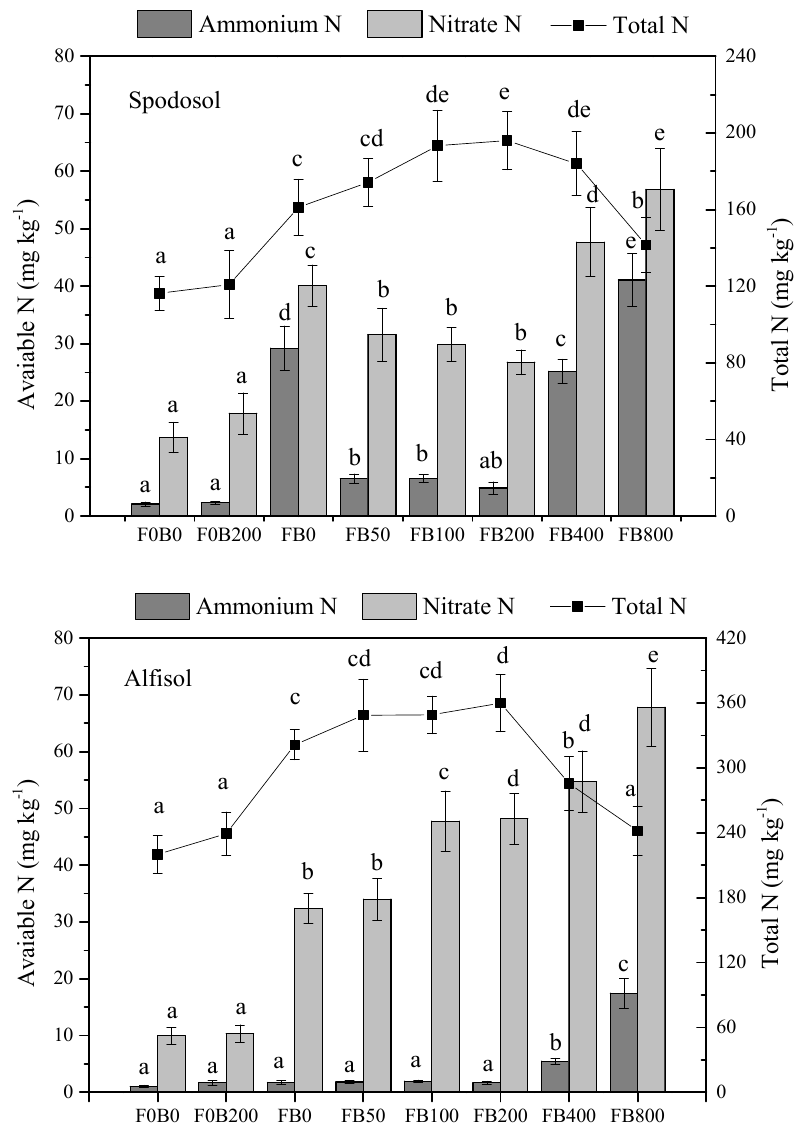
Figure 6. Total and available N concentration in Spodosol and Alfisol soils affected by different application rates of CNPs during the period of corn growth. F0B0, control (without fertilizers and CNPs); F0B200, without fertilizers and with CNPs at 200 mg kg − 1 soil; and FB0, FB50, FB100, FB200, FB400 and FB800 represent those with and CNPs at application rates of 0, 50, 100, 200, 400 and 800 mg kg − 1 soil, respectively. Error bars represent the standard error of the mean ( n = 5). The letters a, b, c, d and e indicate statistically significant difference at p < 0.05 within each group comparison between the treatments. Bars with no common letters are significantly different ( p < 0.05).